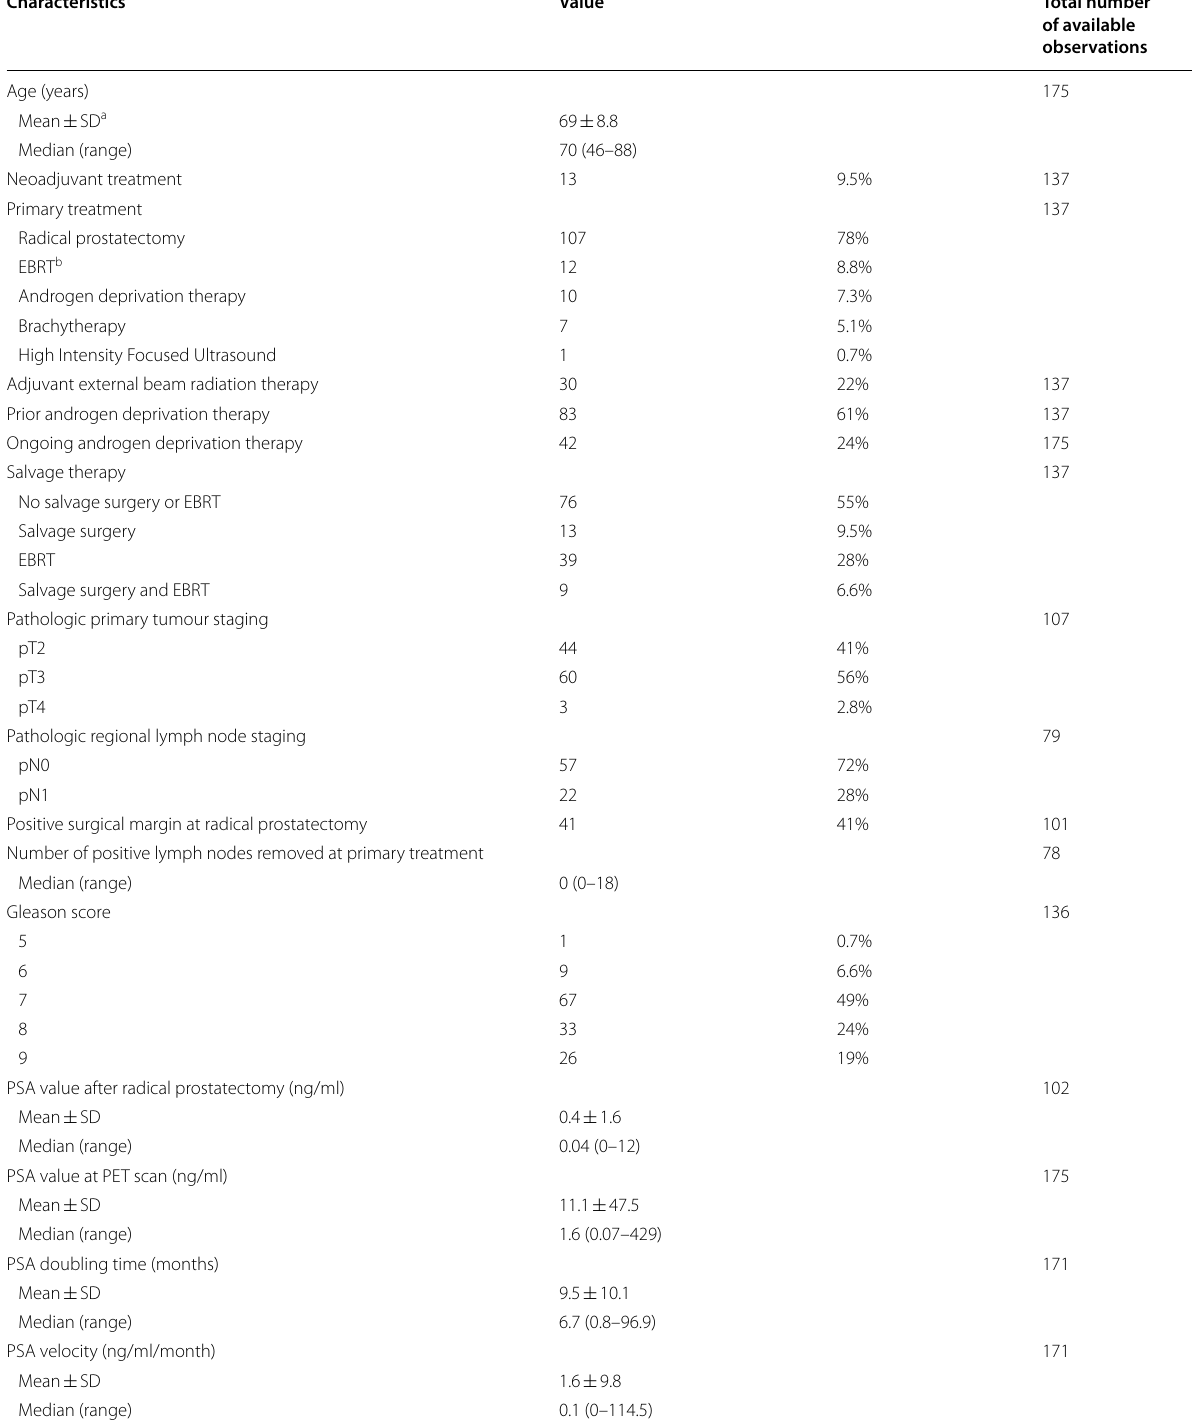
Table 1 Patient and [ 18 F]PSMA-1007-PET/CT